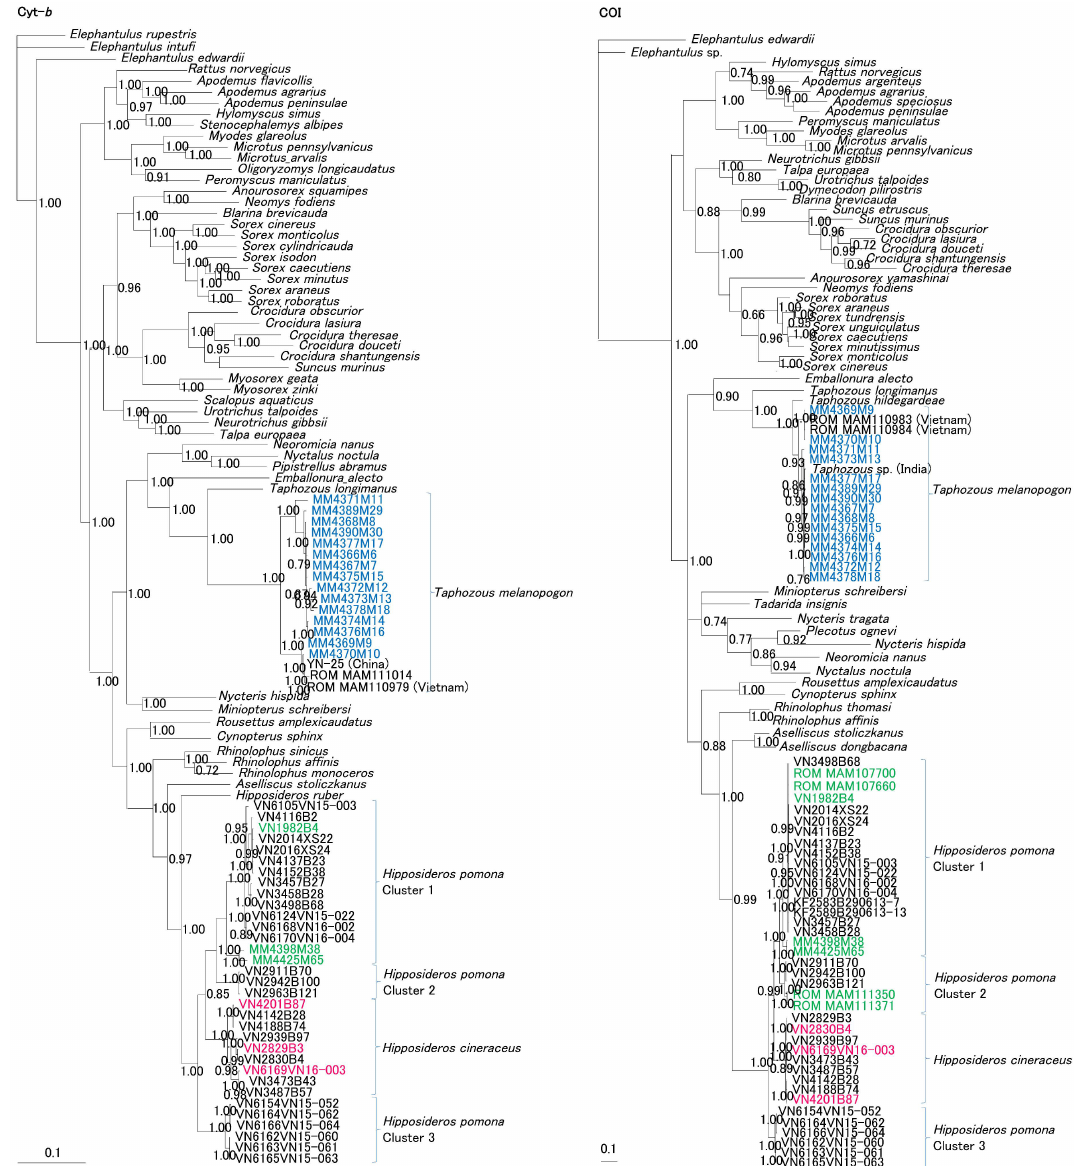
Figure 4. Bayesian phylogenetic trees of the host organisms of mobatviruses reconstructed from the alignments of 1140-nucleotide cytochrome b (Cyt b ) and 1545-nucleotide cytochrome oxidase I (COI) gene sequences. Taphozous melanopogon collected in Myanmar (blue), XSV-positive Hipposideros pomona (green) in Myanmar and XSV-positive Hipposideros cineraceus (red) in Vietnam are shown. Numbers at the nodes indicate posterior probability values (>0.7) based on 150,000 trees: two replicate Markov chain Monte Carlo runs, consisting of six chains of 10 million generations, each sampled every 100 generations, with a burn-in of 25,000 (25%). Scale bars indicate nucleotide substitutions per site. Gene accession numbers are listed in Table